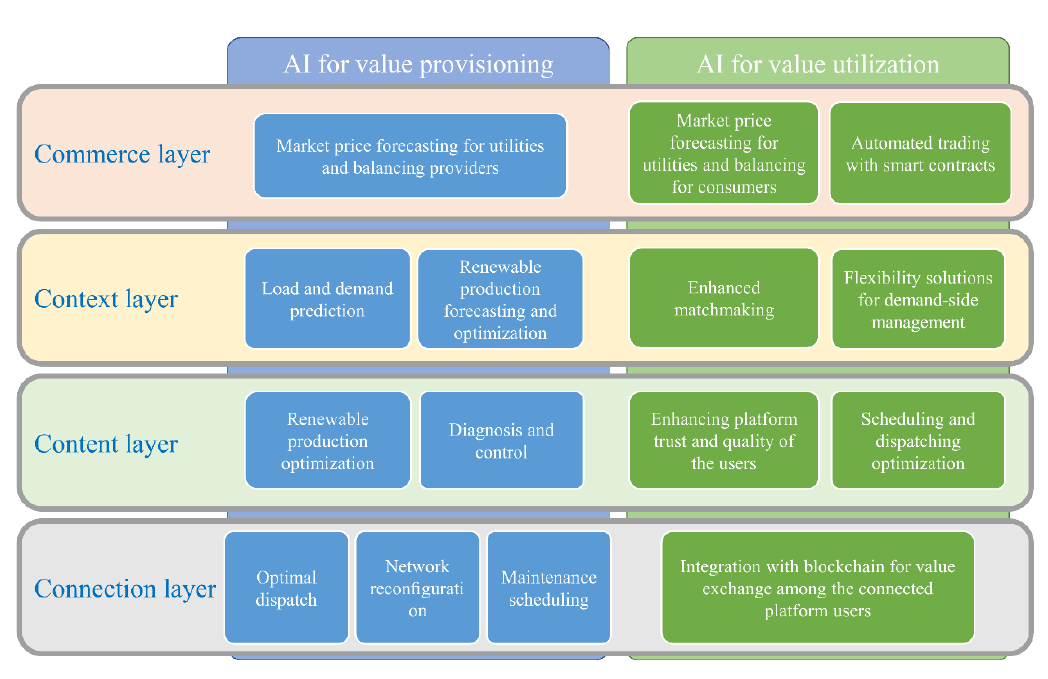
Figure 3. How AI can impact the value provisioning and utilization on the energy platform.